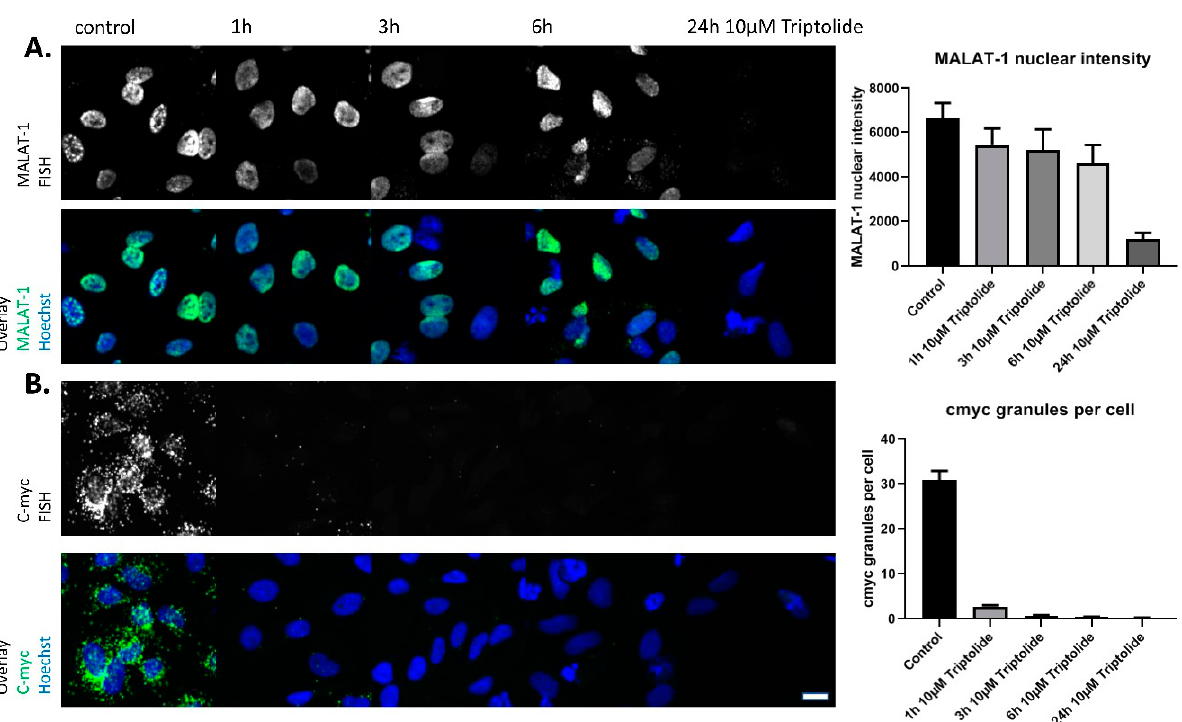
Figure 1. ( A ): Hela stained for MALAT1 lncRNA by fluorescence in-situ hybridization after treatment with transcription inhibitor Triptolide various times. Nuclei are stained by Hoechst. ( B ): Hela stained for c-myc mRNA by fluorescence in-situ hybridization after treatment with transcription inhibitor Triptolide various times. Nuclei are stained by Hoechst. Quantification of nuclear MALAT1 staining or c-myc granules per cell shown on the right. Bars show mean with SD. Scale bar ~10 µm.